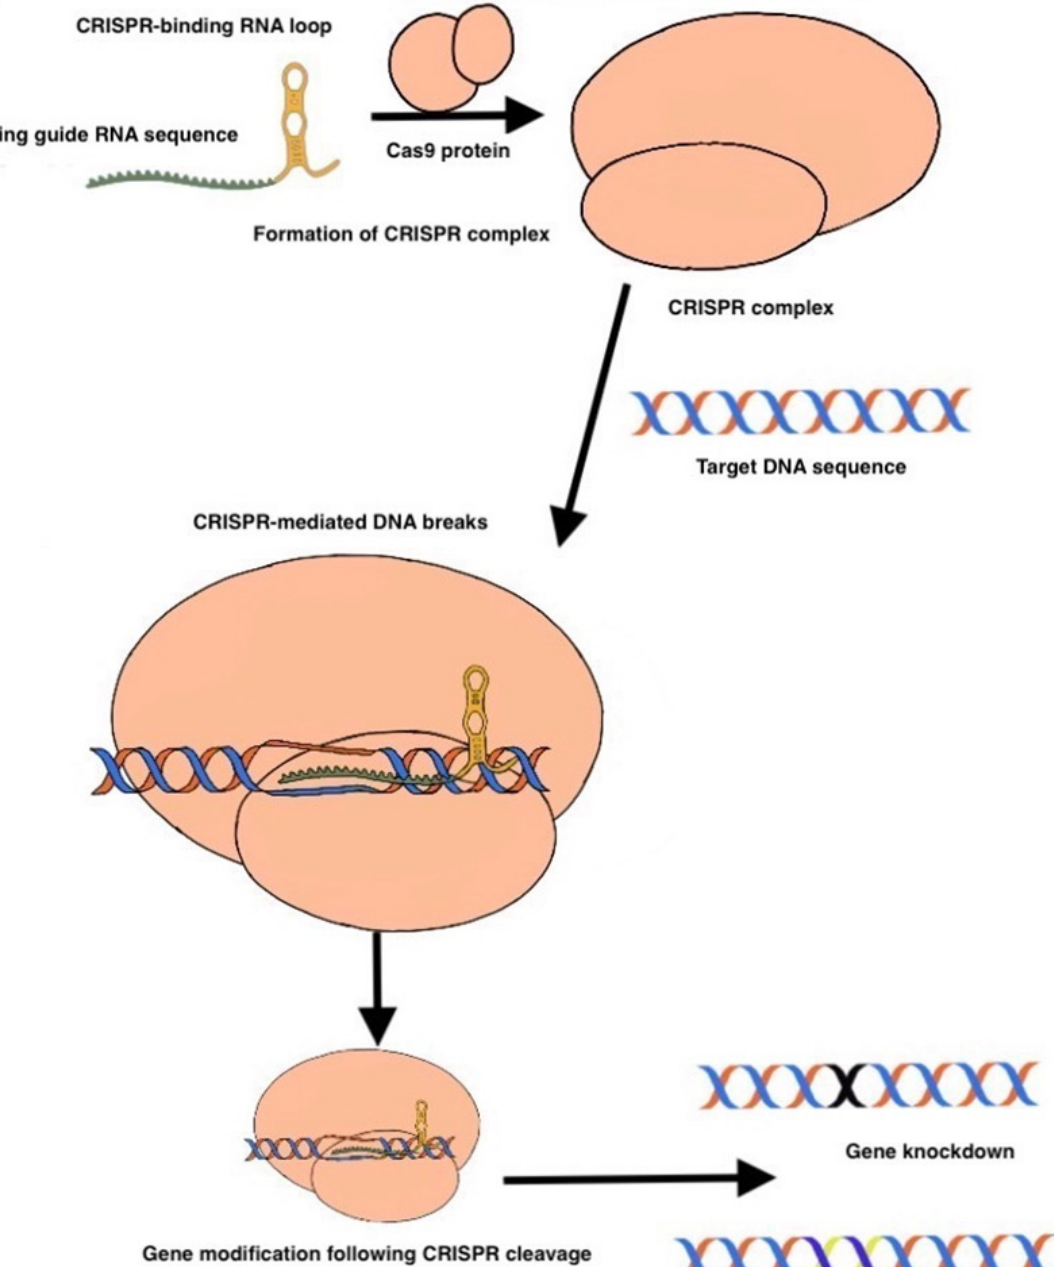
Figure 1. Formation of CRISPR Complex. In the CRISPR/Cas9 system, a guide RNA (gRNA)